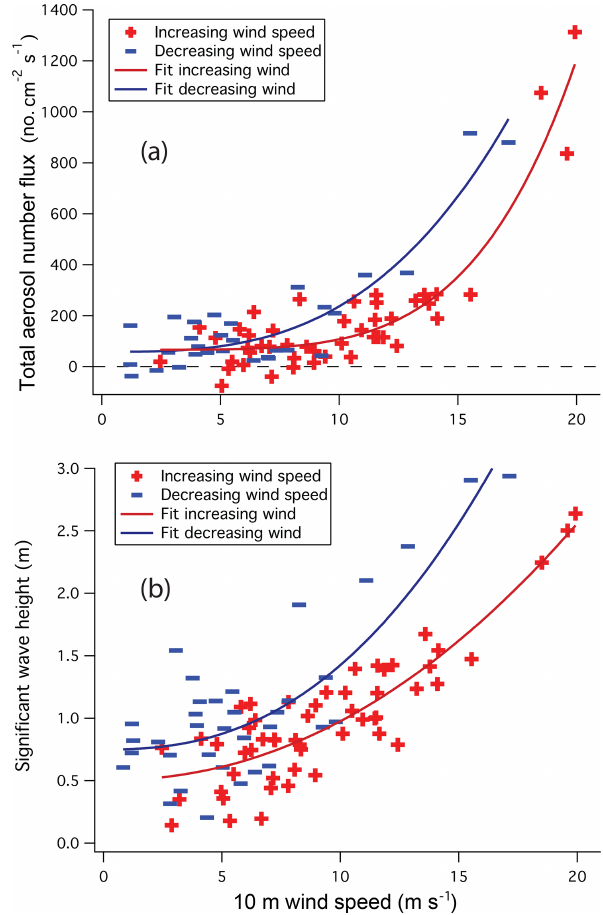
Figure 9. Total aerosol number source flux from the CPC for the southwest, open water wind sector versus wind speed (a) and versus significant wave height (b) . Data on both plots are separated into periods of increasing wind speed (red crosses) and decreasing wind speed (blue dashes; see Sect. 3.2 for